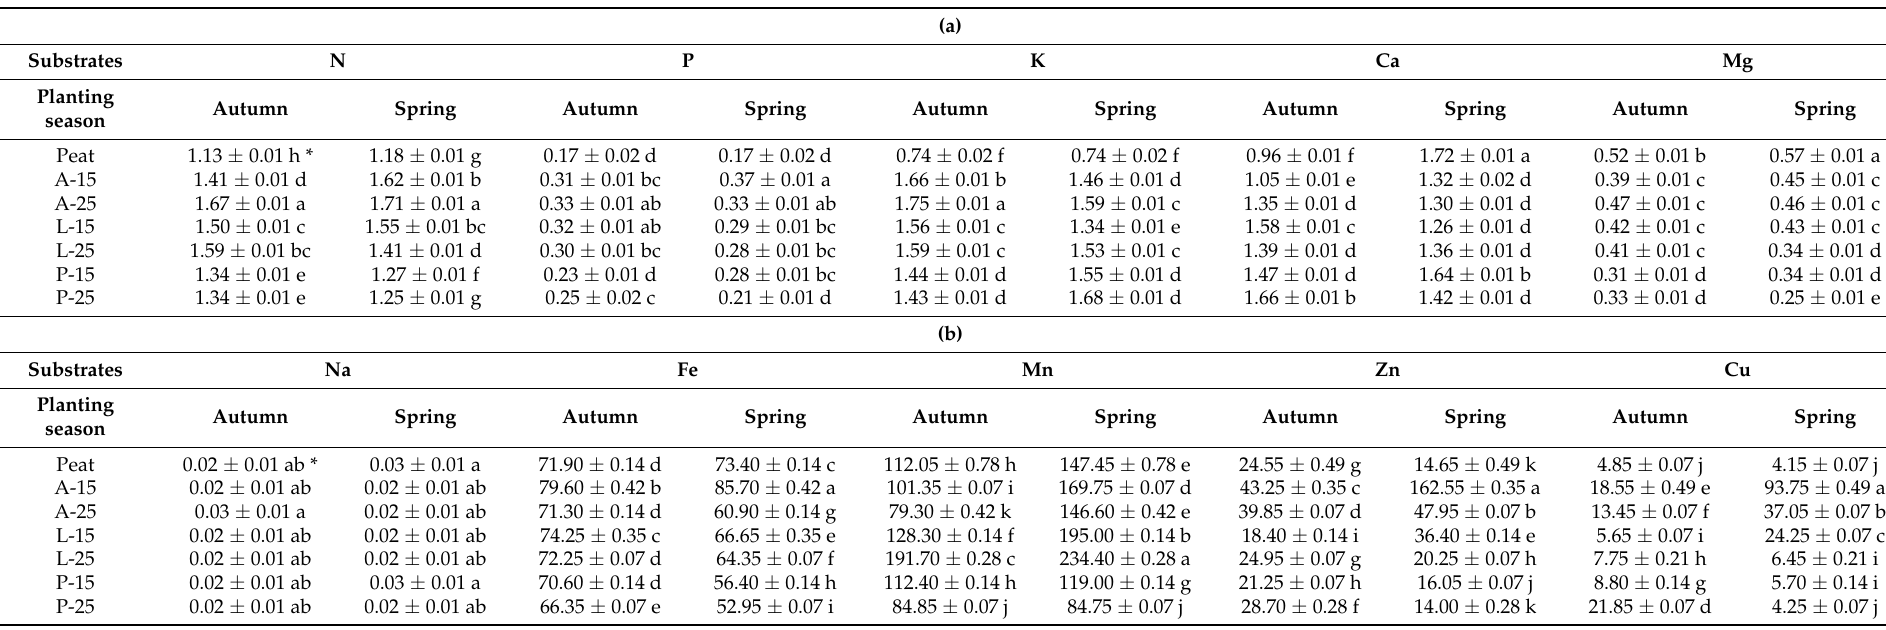
Table 12. ( a ) Macronutrient concentrations in strawberry leaves (%DW). ( b ) Sodium (%DW) and micronutrient (mg · kg − 1 DW) concentrations in strawberry leaves. (a)